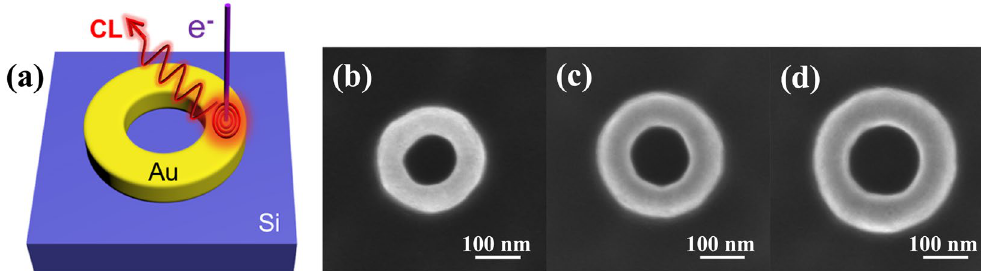
Figure 1. Schematic illustration and SEM images of the Au nanoring cavities. ( a ) Scheme of an Au nanoring cavity on a crystalline silicon substrate. The cavity is excited using electrons and then CL spectra are measured. ( b – d ) SEM images of our fabricated Au nanorings with different inside radii r = 60, 70 and 80 nm, and outside radii R = 2 r .